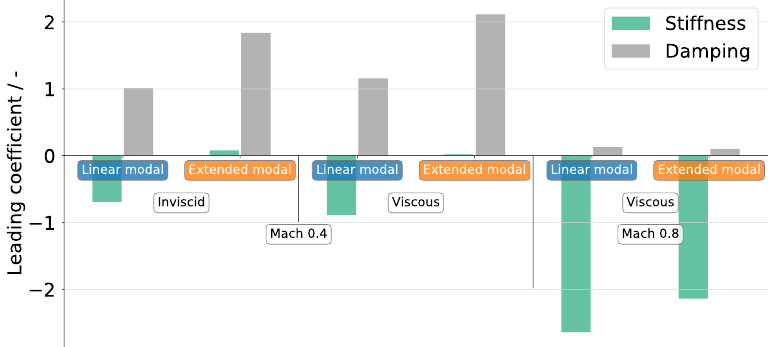
Figure 20. Summary of aerodynamic coupling term nonlinearity (reduced frequency 0.231)